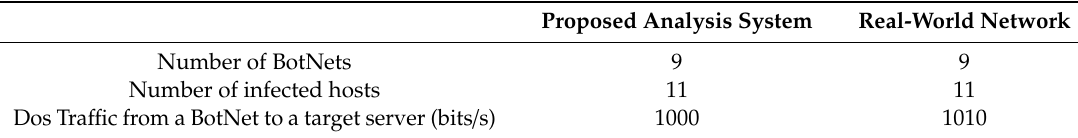
Table 4. Performance evaluation results.